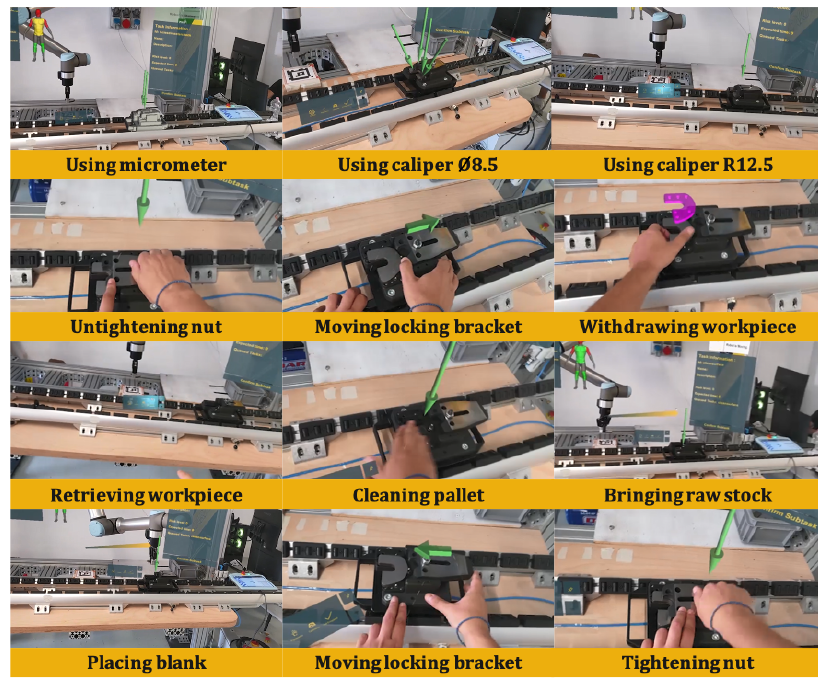
Figure 10. Operator point of view for indicative tasks (AR